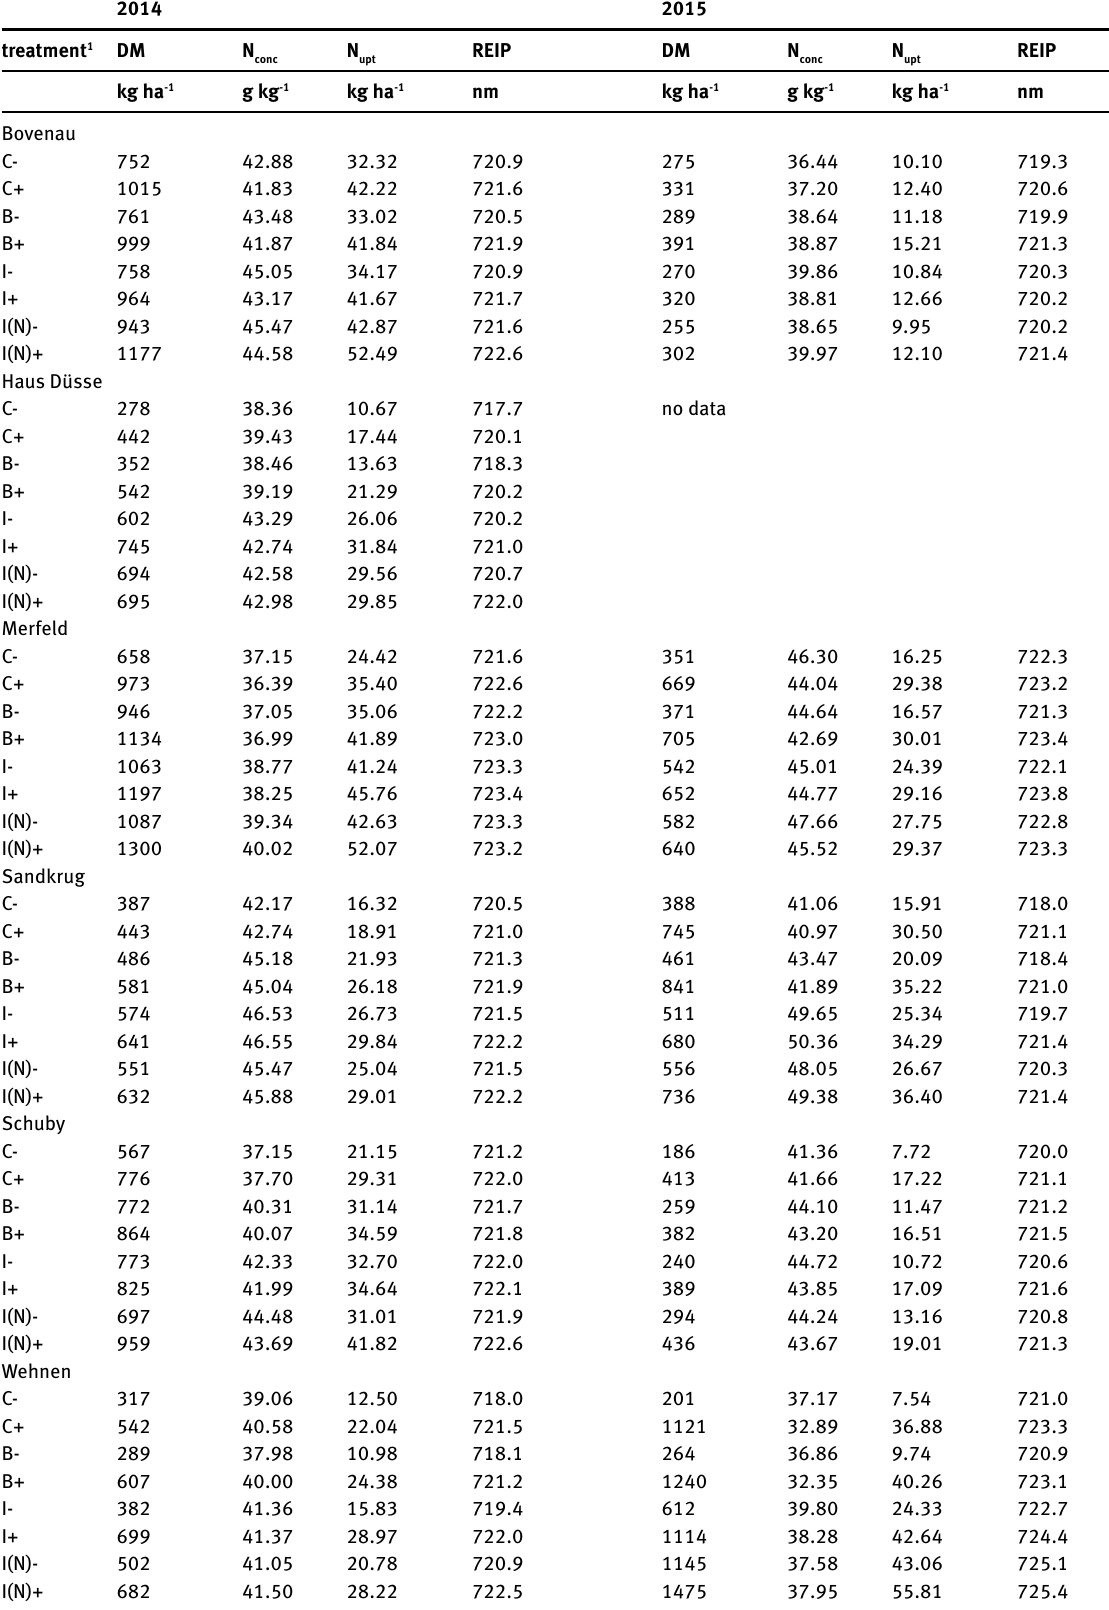
Supplementary Table 7: Raw data means of four replications for aboveground dry matter biomass (DM), whole plant nitrogen concentrations (N ), plant nitrogen uptake (N ) and red edge inflection point (REIP) for the treatments an V8 growth stage in the experimental conc upt